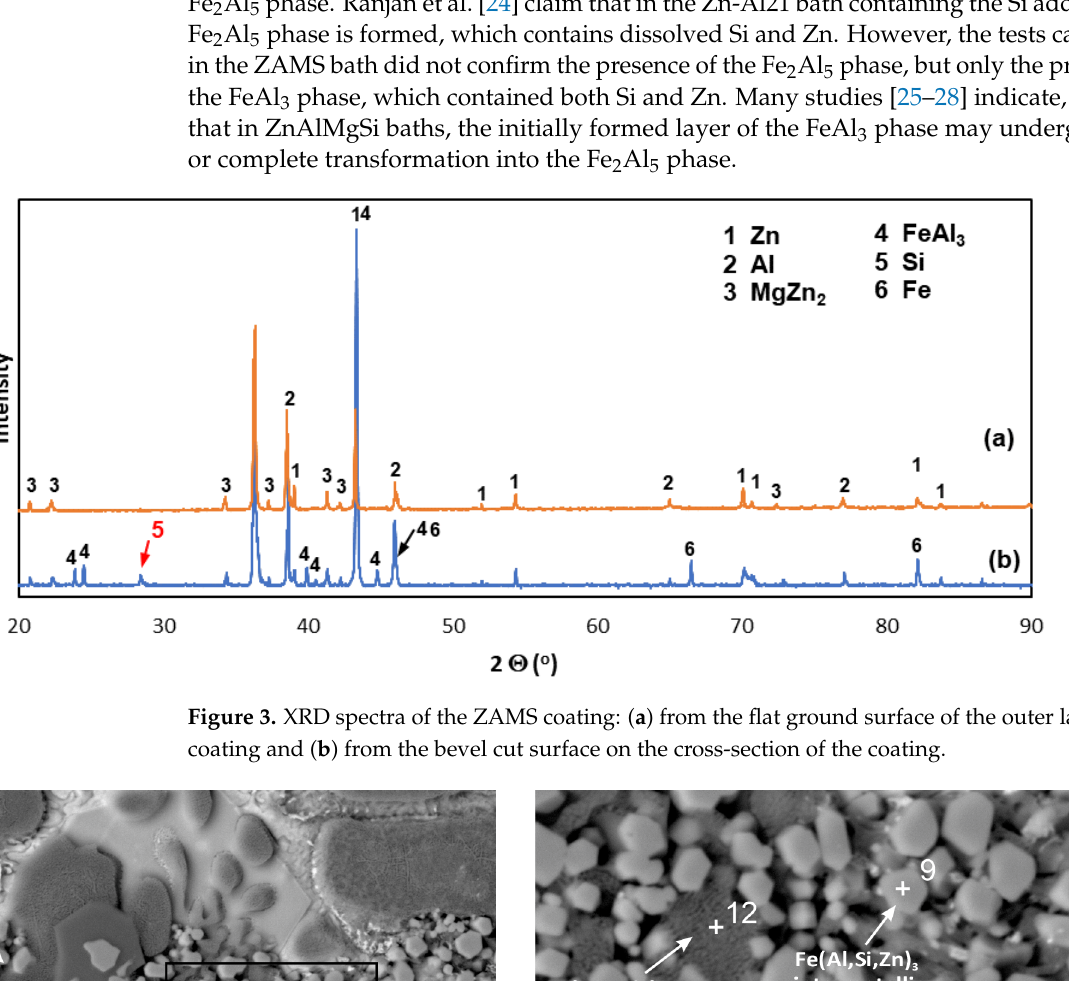
Figure 3. XRD spectra of the ZAMS coating: ( a ) from the flat ground surface of the outer layer of the coating and ( b ) from the bevel cut surface on the cross-section of the coating.